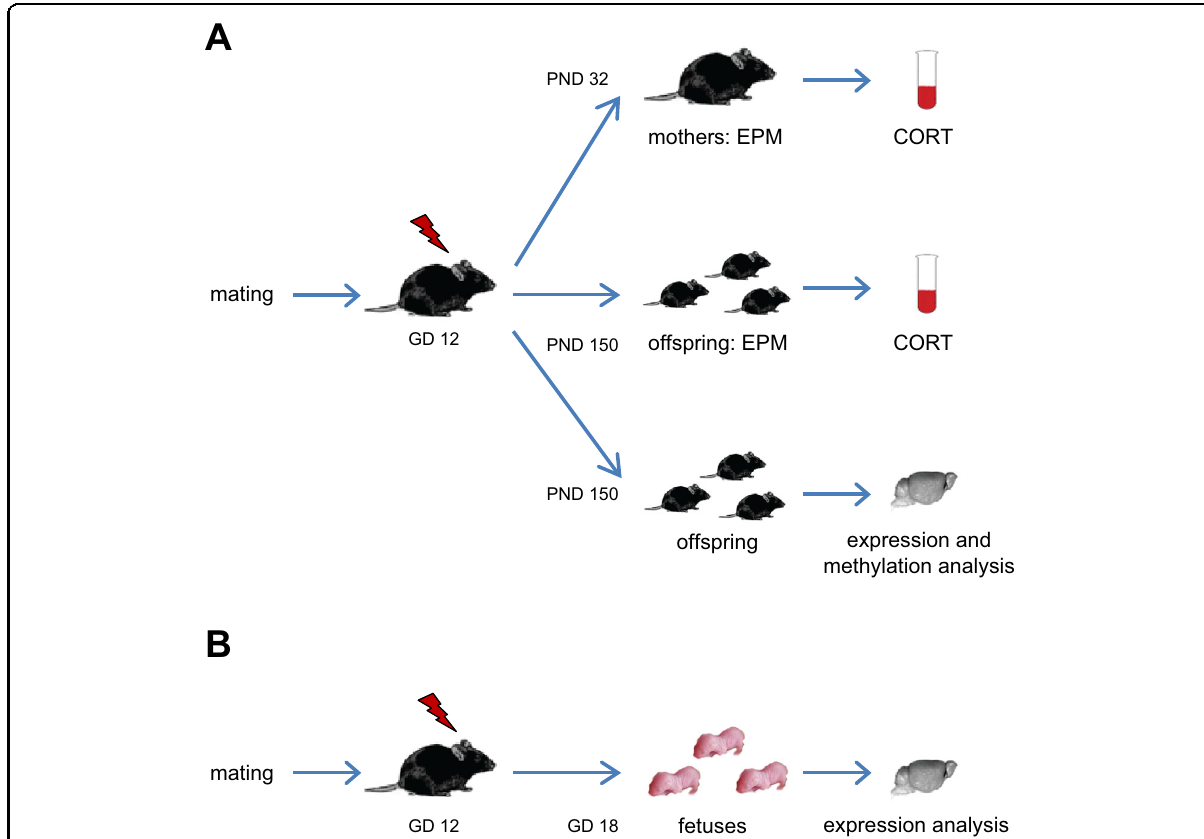
Fig. 1 Experimental scheme. Schematic overview of experiment 1 ( A ) and experiment 2 ( B ). Lightning symbol = traumatic experience (electric foot shock) of the MT group; GD gestational day, PND postnatal day, EPM elevated plus